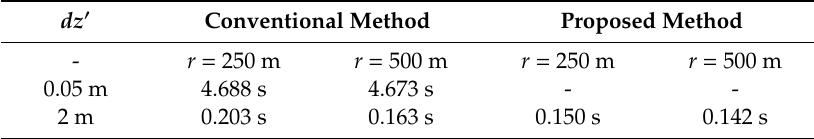
Figure 6. The horizontal electric field curves at the different observation points calculated by the proposed method and the conventional method under different dz ’. ( a ) the horizontal electric field at r = 250 m calculated by two methods; ( b ) the horizontal electric field at r = 500 m calculated by two methods. Table 4. Comparison of the computation time between the two